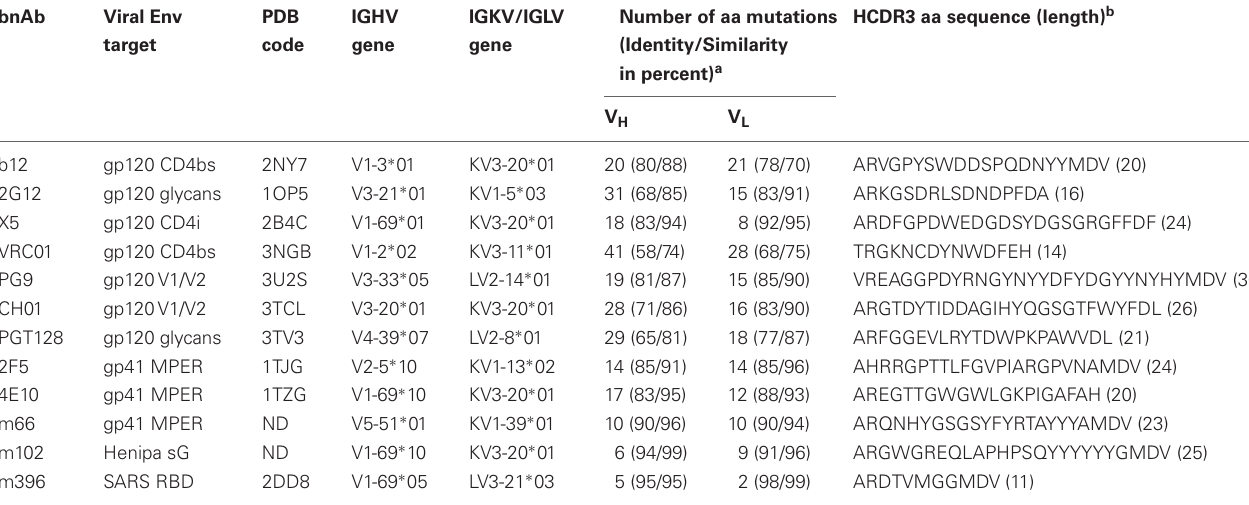
Table 1 | Antiviral bnAbs against the HIV-1, SARS CoV and Henipaviruses, and their related sequence, structure, and immunogenetics